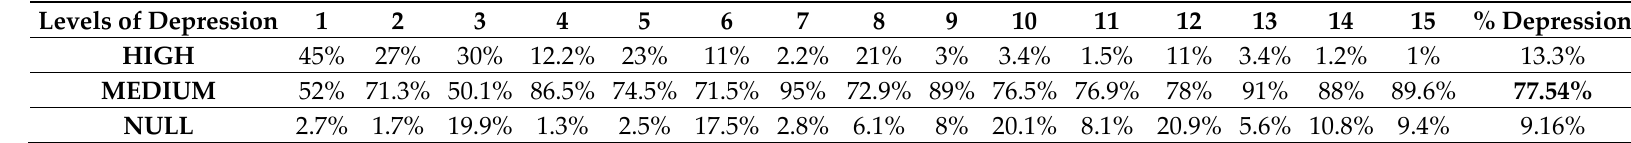
Table 3. Values converted into percentages one older